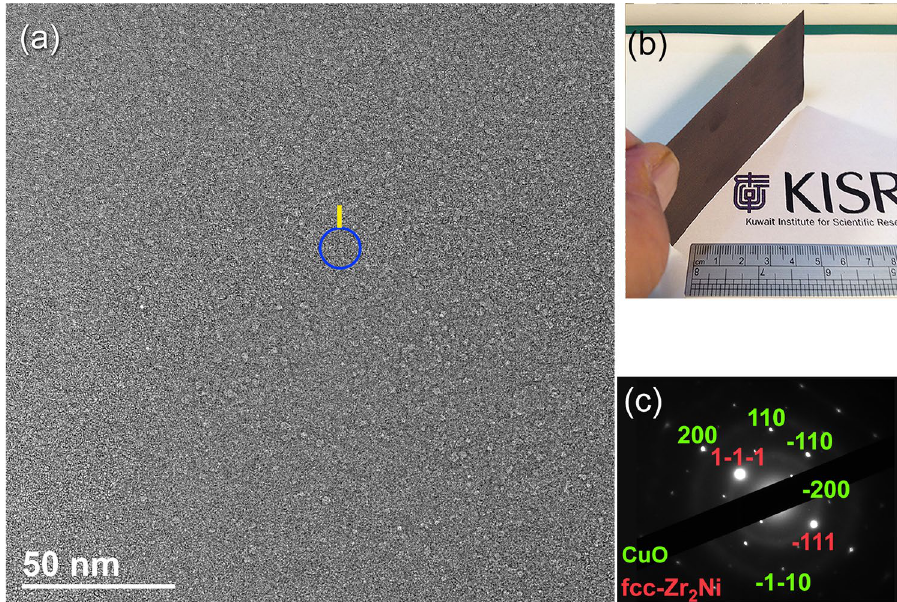
Figure 12. ( a ) FE-HRTEM image of MG powders that were coated on ( b ) SUS 304 substrate (inset of the figure). The indexed NBDP of the circular symbol shown in ( a ) is displayed in ( c